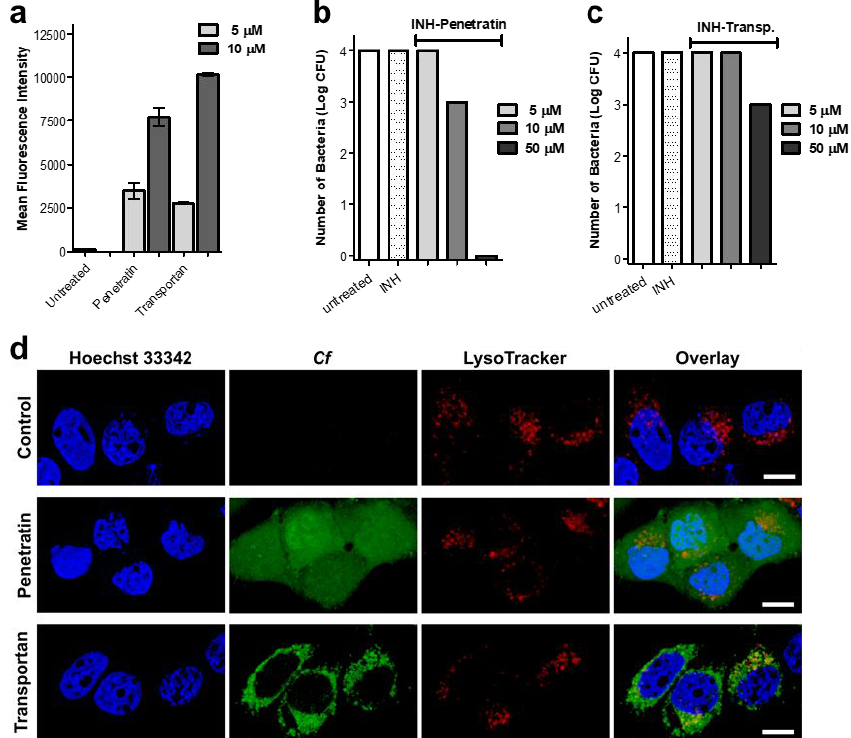
Figure 7. Internalization and intracellular antibacterial activity of the peptides. Cellular uptake of EBC-1 human lung carcinoma cells was measured by flow cytometry after 2 h treatment with 5 and 10 µ M peptide concentrations ( a ). Localization of 5(6)-carboxyfluorescein-labeled Penetratin